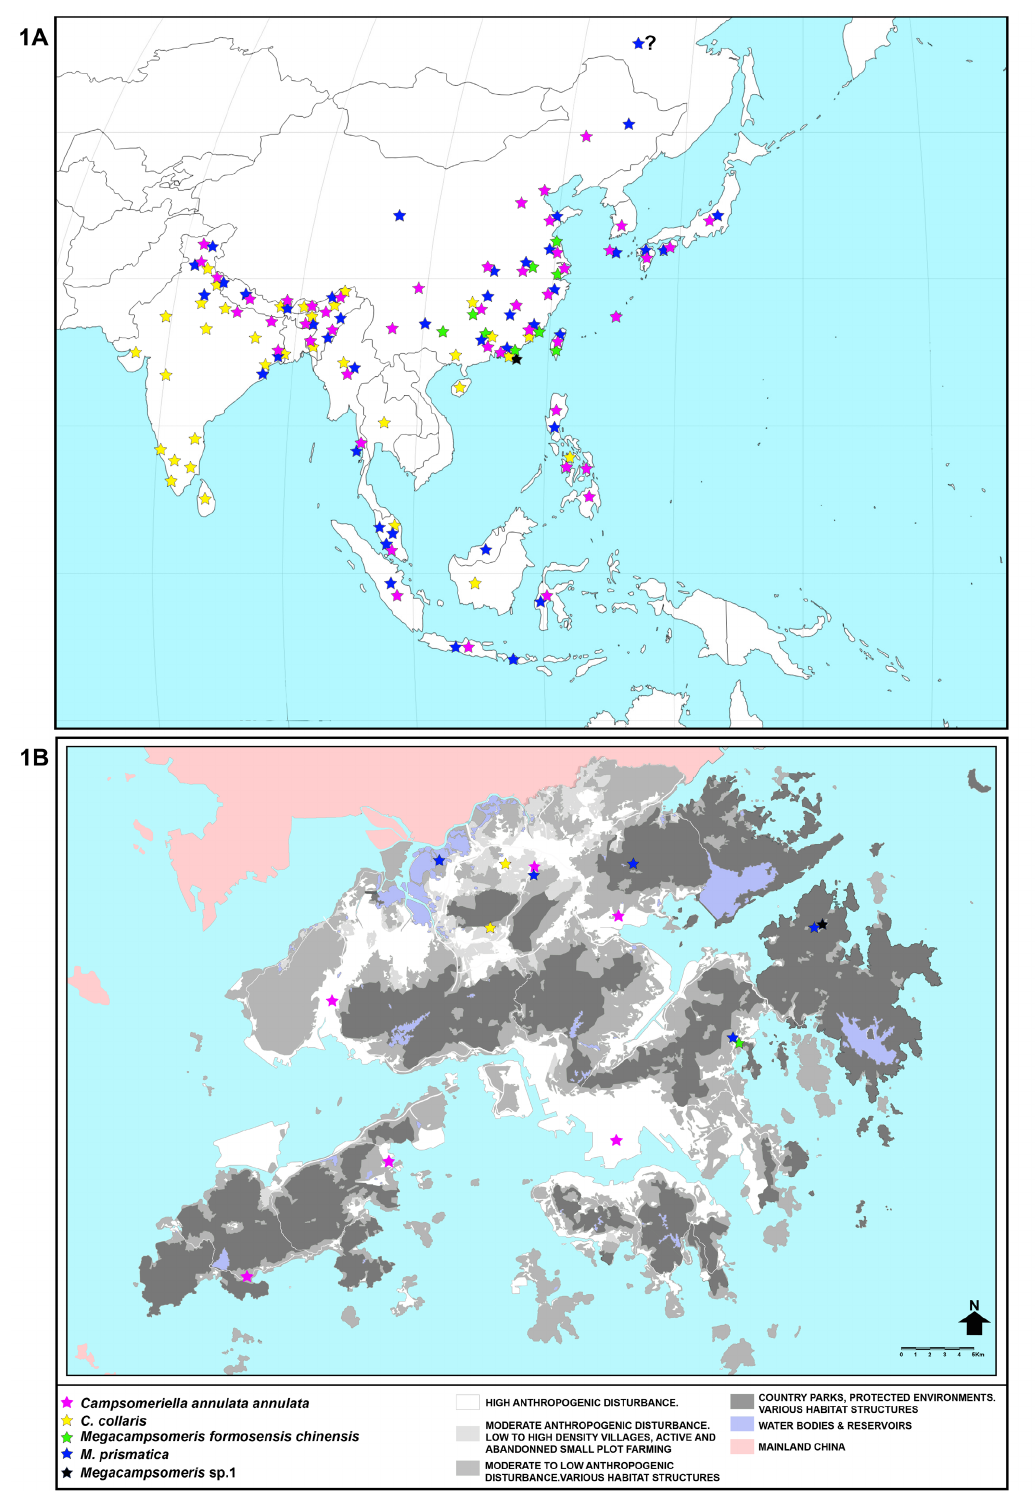
Fig. 1. Distribution of four species in the tribe Campsomerini Bartlett, 1912: Campsomeriella annulata annulata (Fabricius, 1793), Camps. collaris (Fabricius, 1775), Megacampsomeris formosensis chinensis Betrem, 1941, Megacam. prismatica (Smith, 1855) and Megacampsomeris sp. 1. A . World distribution. B . Hong Kong